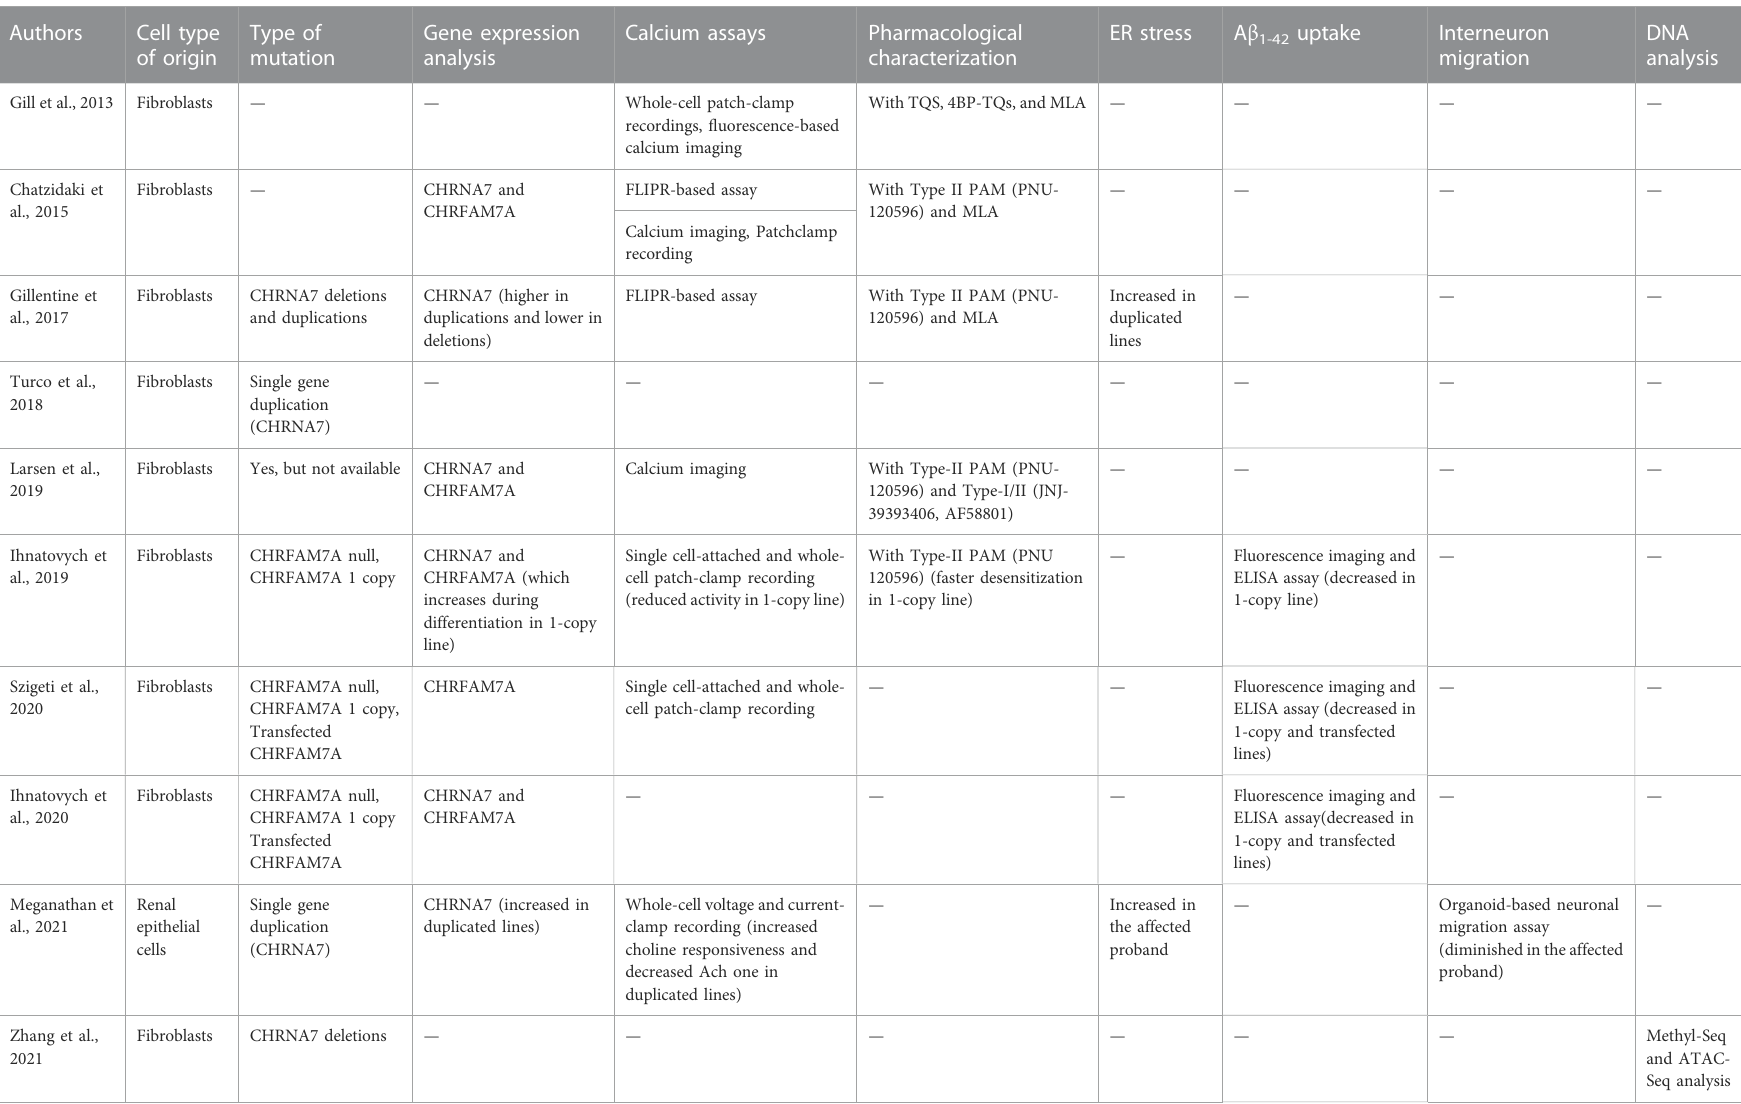
TABLE 1 Summary of the studies based on the hiPSCs model for studying 15q13.3